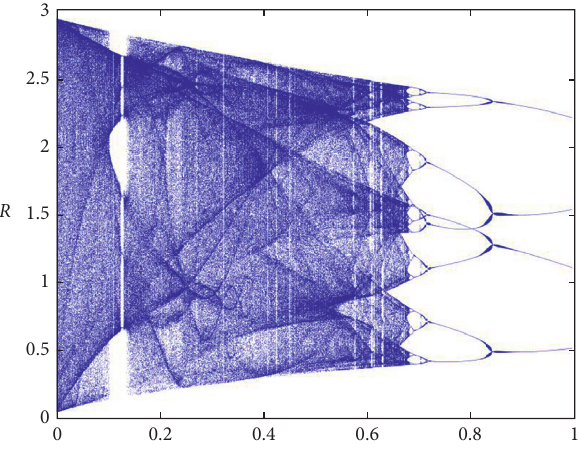
Figure 7: Bifurcation diagram with respect to α .